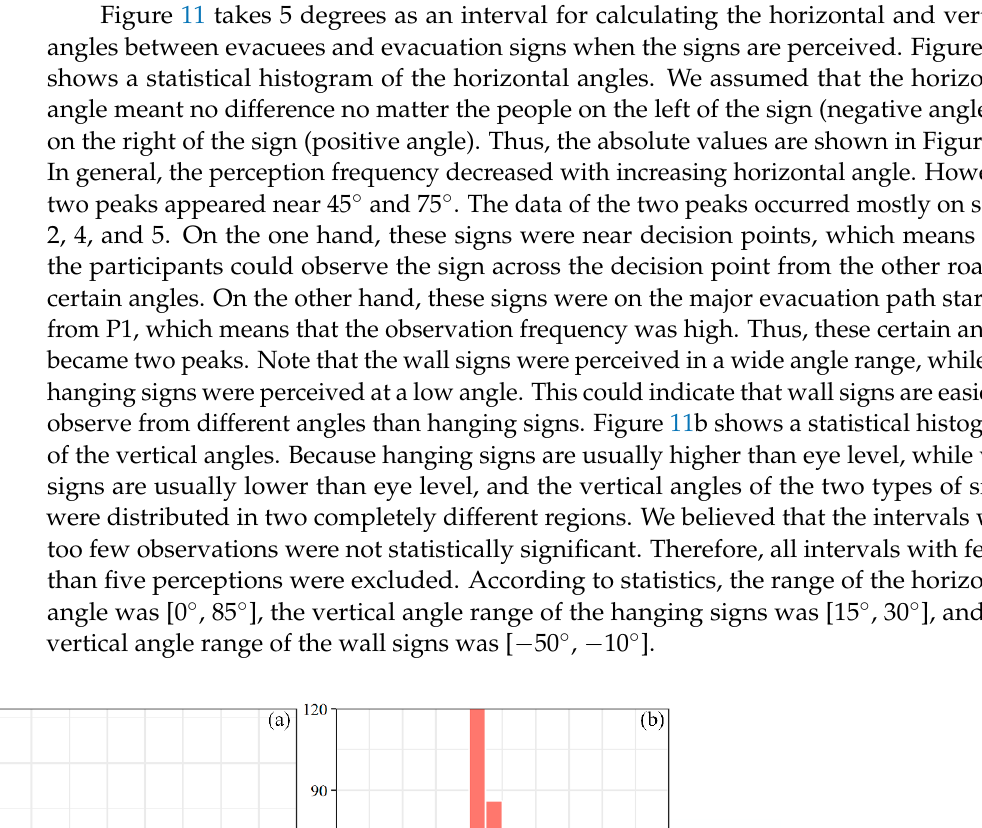
normal distribution, with a mean of 3.22 m and a variance of 0.93 m (cid:2870) . Taking the 95% confidence interval, we obtained a maximum perception distance of approximately 5.15